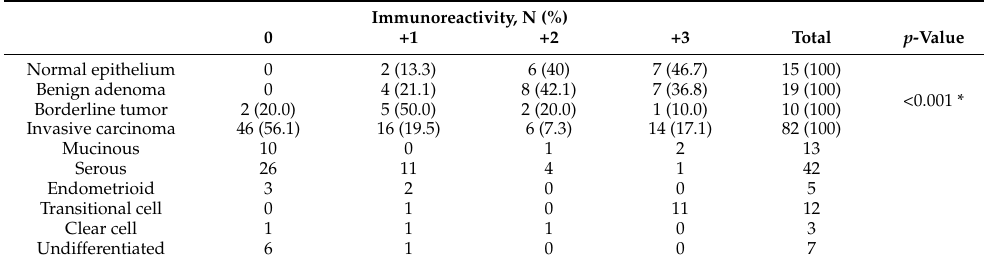
Figure 1. Immunoreactivity of DKK3 and survival curves for patients with invasive serous ovarian cancer. ( a ) DKK3 immunoreactivity in normal epithelium and serous tumors. ( b ) Immunoreactivity of each score in invasive serous carcinoma. ( c ) Kaplan–Meier curves for disease-free survival. Magnification 200 × . Table 1. Expression of DKK3 in different ovarian tissue samples.